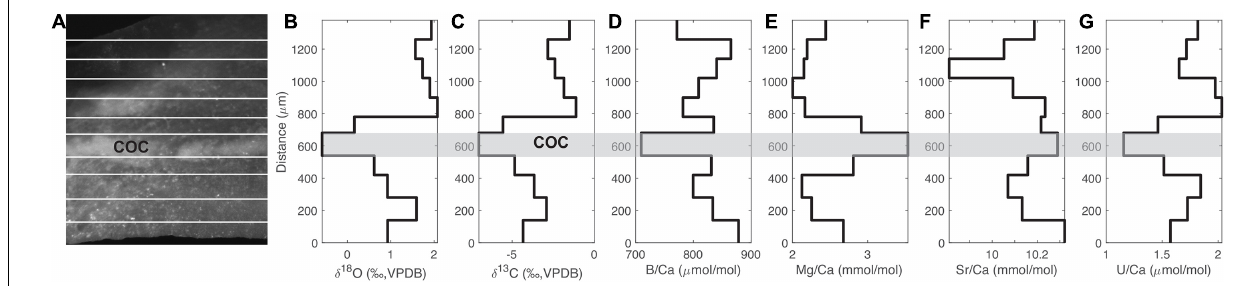
FIGURE 2 | Distribution of isotopes and Me/Ca ratios with growth bands in coral 47394. (A) Reflected light image of a thick section of the coral septum that was micromilled, with white lines showing the micromilled bands. There is a COC band in the middle. (B–G) Transects of δ 18 O, δ 13 C, B/Ca, Mg/Ca, Sr/Ca, and U/Ca of the micromilled bands. The gray bar marks the COC